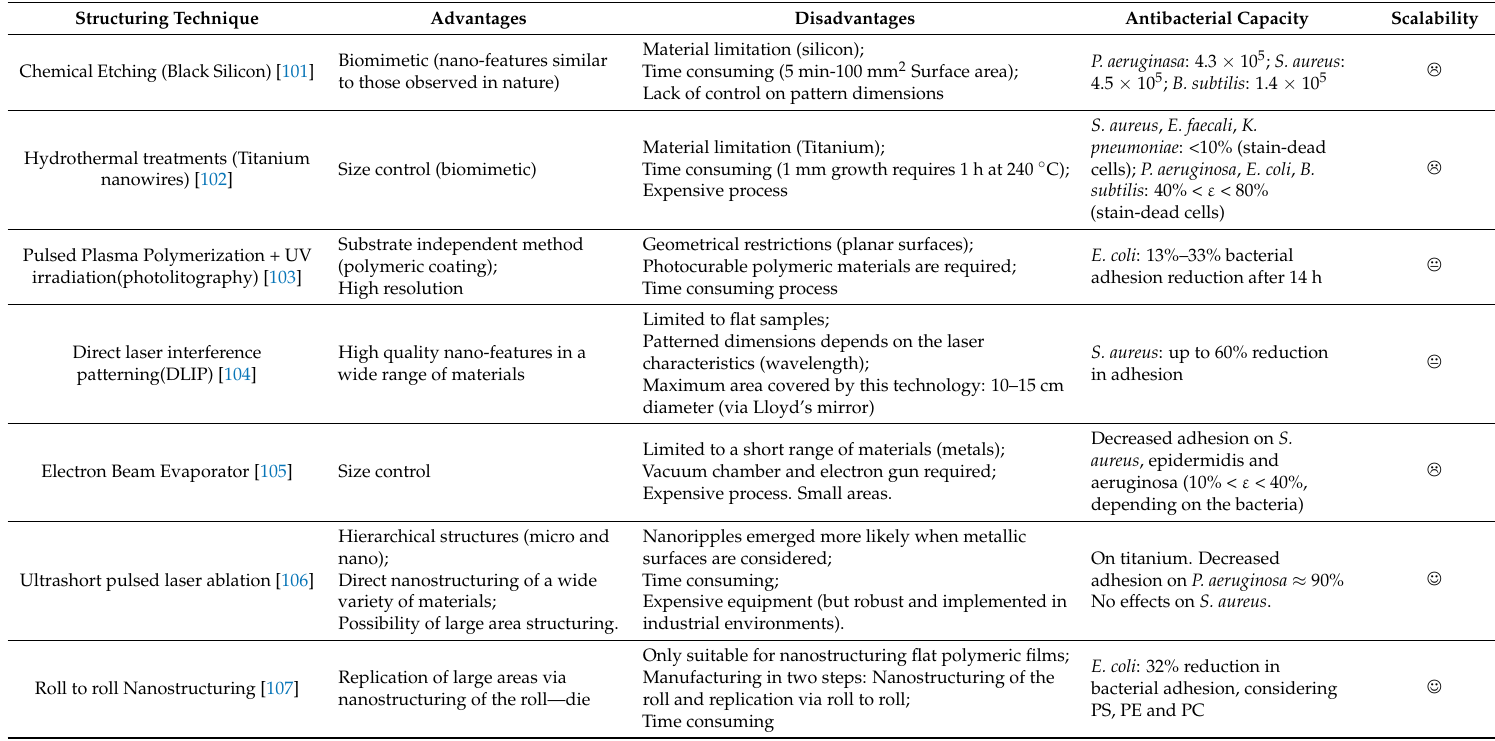
Table 4. Micro- and nano-patterning technologies used for manufacturing antibacterial surfaces: Advantages and Disadvantages.